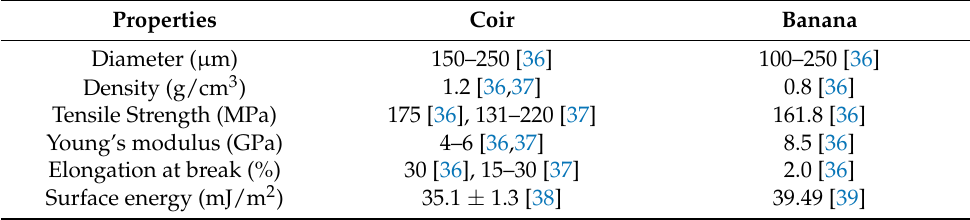
Table 2. Mechanical and physical properties of the fibers.